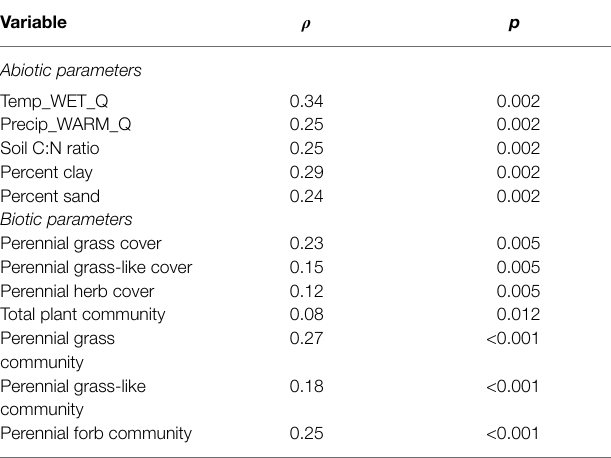
Value of p is corrected for multiple testing according to